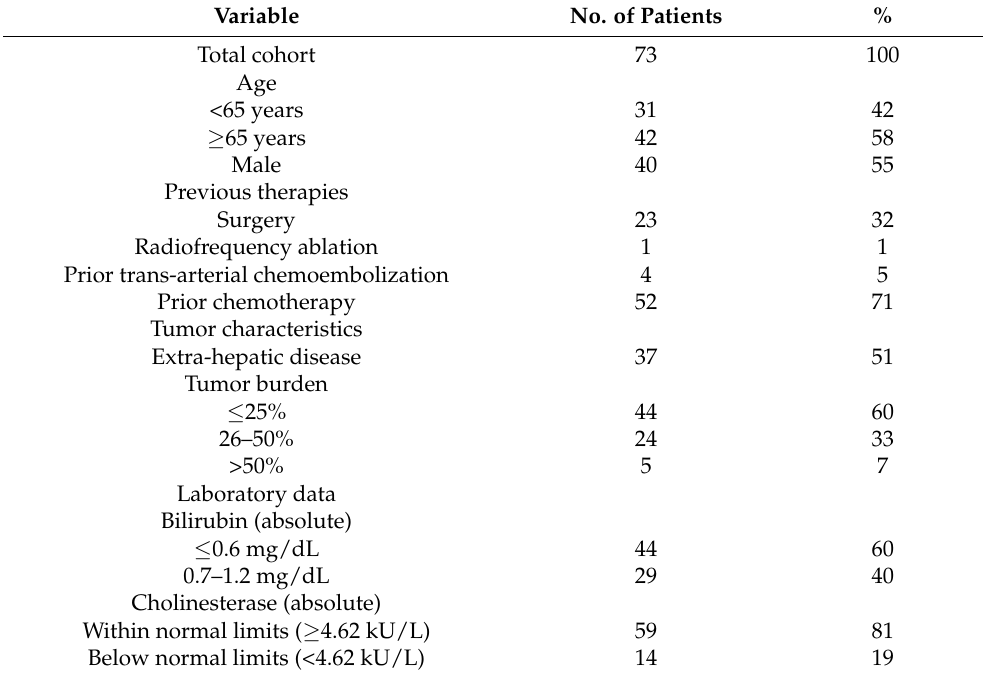
Table 1. Baseline characteristics.